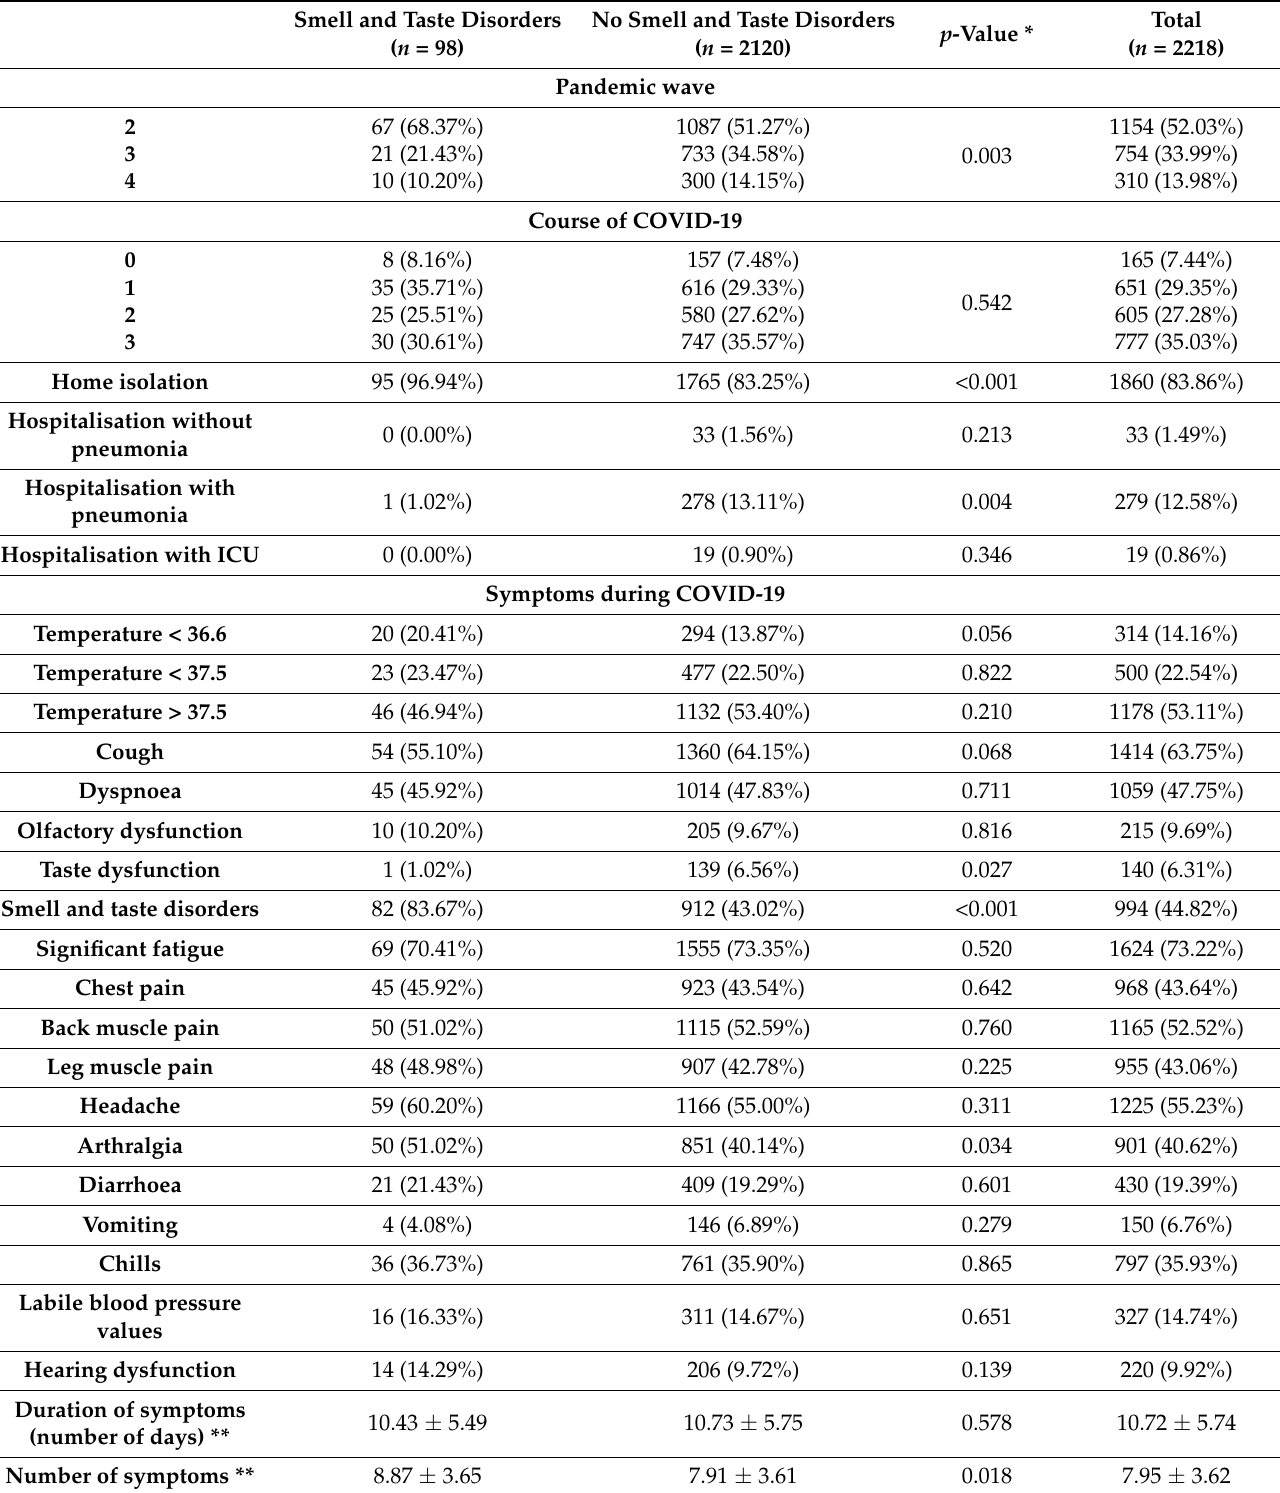
Figure 1 show a detailed summary of the data. Table 2. COVID-19 course analysis in groups with and without persistent smell and taste